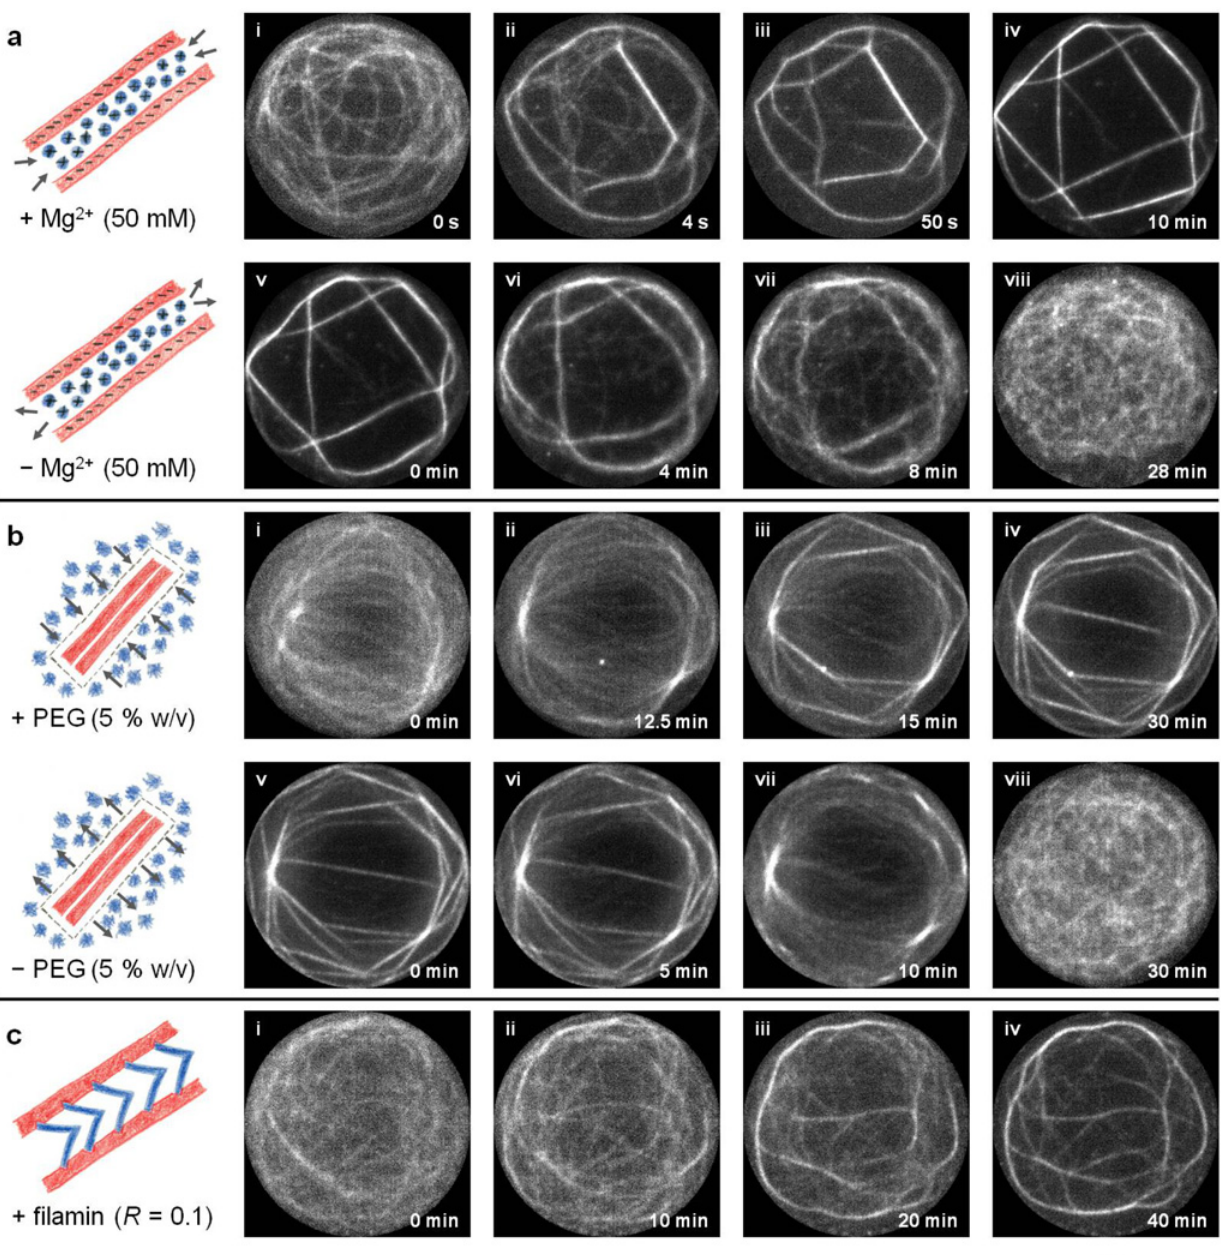
Fig 2. Evolution of emerging actin networks induced by counterion condensation, depletion interactions and specific binding interactions. Time- lapse images of emerging networks of actin bundles from semi-dilute solutions of confined actin filaments (3 μ M, l avg (cid:3) 10 μ m) by (a) Mg 2+ ions (50 mM), (b) PEG polymers (5% w/v, M. W. 8000) and (c) filamin dimers (ratio of filamin to actin ( R ) = 0.1). Images i-iv show the formation of networks while images v-viii show their disassembly upon addition and depletion of bundling agents respectively. Scale bar represents 10 μ m.